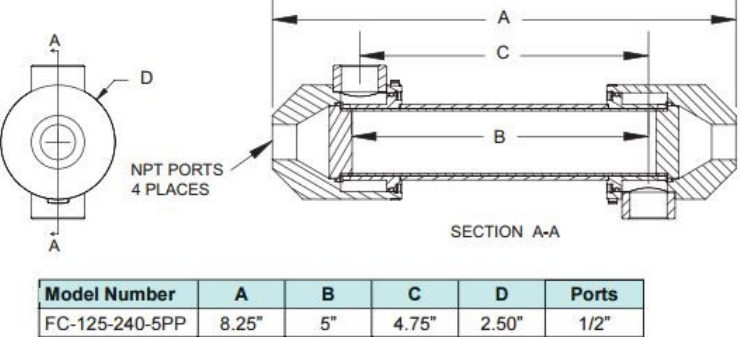
Figure 2. Technical drawing of the internal construction of the Nafion Tubing